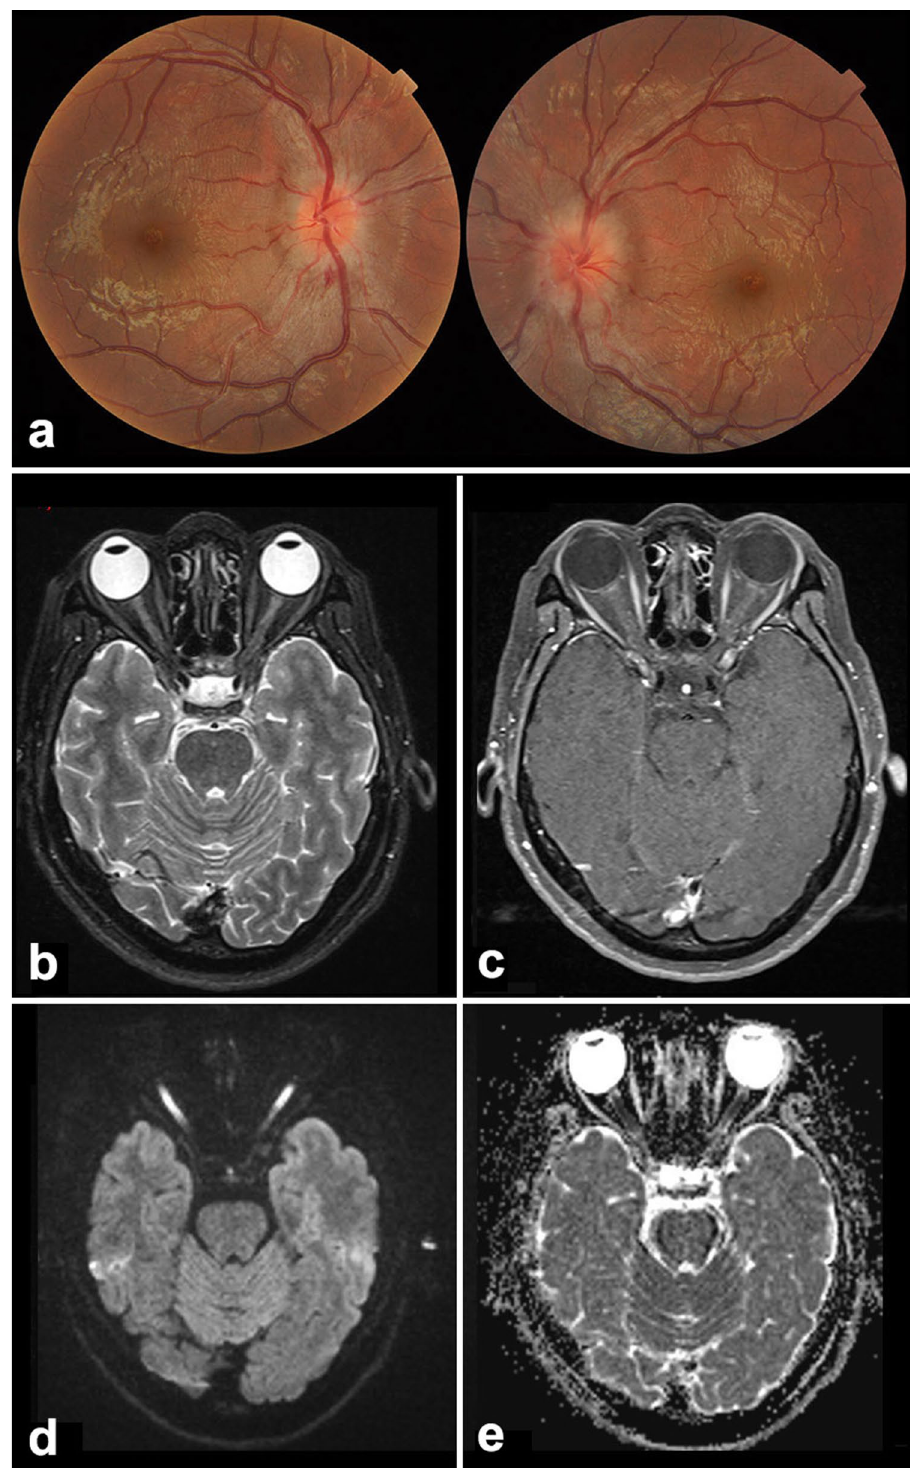
Figure 3. A 20-year-old young man with acute profound bilateral visual loss, seronegative for myelin oligodendrocyte glycoprotein and aquaporin 4 antibodies. ( a ) The disc is swollen bilaterally with hemorrhage; ( b – e ) Orbit magnetic resonance imaging (MRI) at the acute stage showing mild hyperintensity of the optic nerves on T2-weighted imaging (WI) ( b ), no enhancement on T1WI after contrast ( c ); diffusion-weighted MRI ( d ) showing extreme hyperintensity of bilateral optic nerves with reduced apparent diffusion coefficient ( e ) value, indicating severe damage of the nerve. The best-corrected visual acuity at the 3-year follow up was 20/400